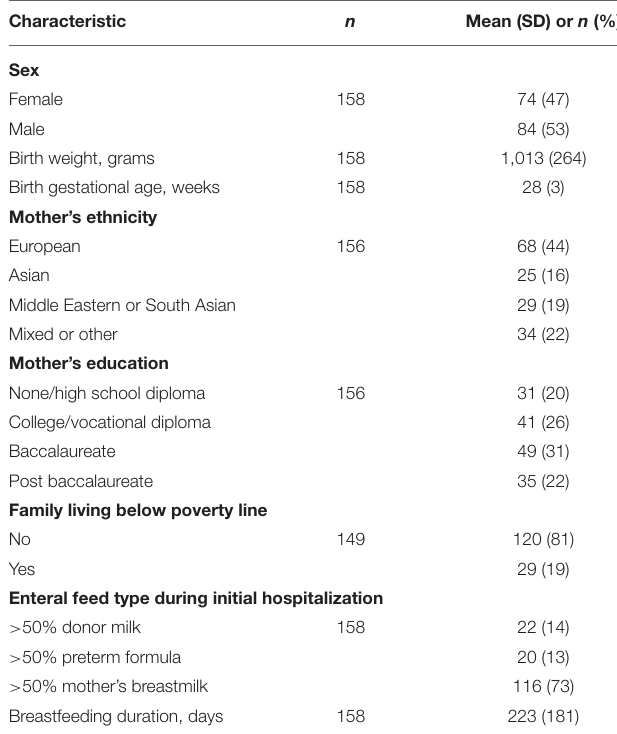
TABLE 1 | Birth and parental baseline characteristics of children and families who participated in follow-up at 5 years.